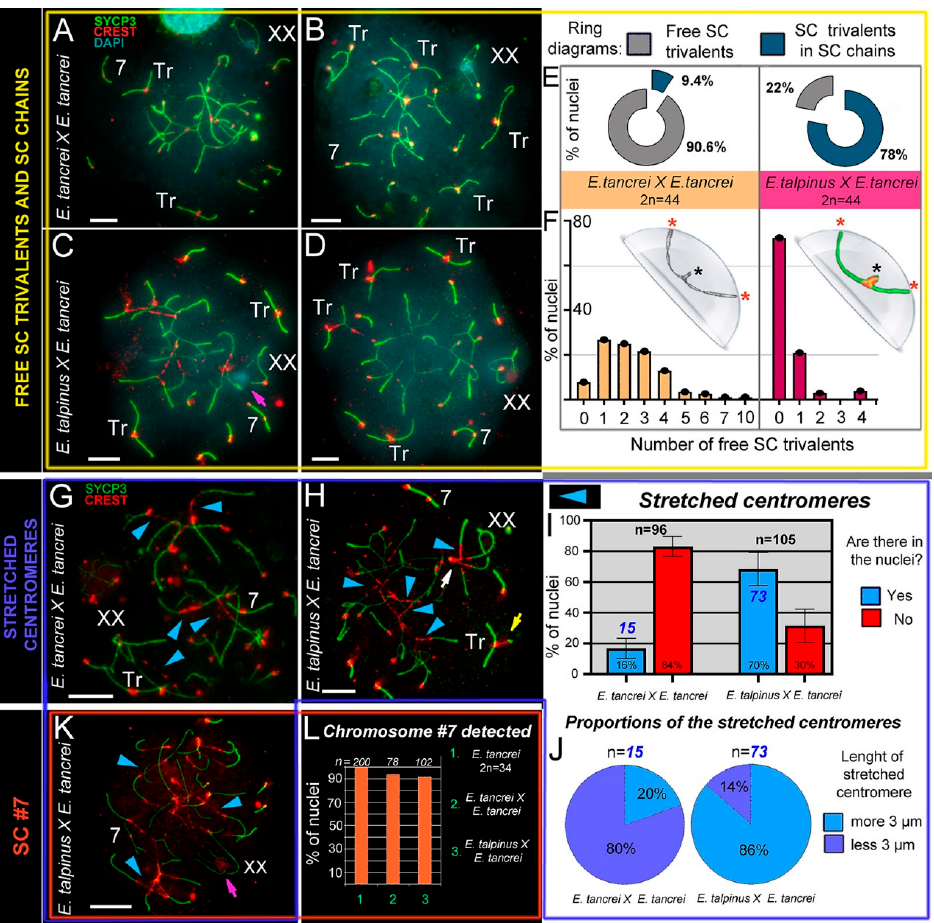
Figure 3. SC trivalents and stretched centromeres in Ellobius hybrids. ( A–F ) SC trivalents, free and in chains, in 44-chromosome intraspecific ( A , B ) and interspecific ( C , D ) hybrids. Both hybrids had variations in the number of free closed trivalents (see A–D ). Fewer free closed SC trivalents in the nuclei indicated that more open SC trivalents were in the chains. The number of free trivalents in hybrid nuclei was significantly different: 90.6% in intraspecific ( n = 99) and 22% in interspecific ( n = 102) hybrids (see ring diagrams in E and see Table S1). There were typically 1–4 free SC trivalents identified in most nuclei of intraspecific hybrids (see the light orange columns of the bar chart in F). As a rule, there were no free SC trivalents in most nuclei of interspecific hybrids (see the dark-red columns of the bar chart in F). Free closed SC trivalents simulated in the hemisphere ( F ): black stars show proximal telomeres of acrocentrics, and red stars show distal telomeres of metacentrics and acrocentrics of SC trivalents. ( G – K ) Stretched centromeres in SC trivalents (blue arrowheads in G,H,K ). The prevalence of the stretched centromeres in hybrid nuclei was variable: 16% (15 nuclei from n = 96) in intraspecific and 70% (73 from n = 105) in interspecific hybrid (see bar chart in I ; Table S1 indicates significant differences). The length of the stretched centromeres was different; there were two notable groups: (1) <3 μ m and (2) >3 μ m. Group (1) prevailed in the intraspecific hybrid, while group (2) was more prevalent in the interspecific hybrid (see ring diagrams in J ). (L) Prevalence of chromosome #7 detected in the parent (2 n = 34) and hybrids. Chromosome #7 was clearly identified in all nuclei (see A – D , G , H and K ). Parents (2 n = 34) always had chromosome #7 (without chromosome associations). Both types of hybrids had chromosome #7 in the vast majority of pachytene nuclei (see the columns of the bar chart in L). Pink arrows show associations of the sex (XX) bivalents ( C , K ). The white arrow shows atypical lengthening of one of the XX bivalent synaptic sites ( H ). The yellow arrow shows atypical prolonging of short arms of acrocentrics of the SC trivalent ( H ). The nucleus in K is presented in Figure S6A–G). Scale bars represent 5 μ m.